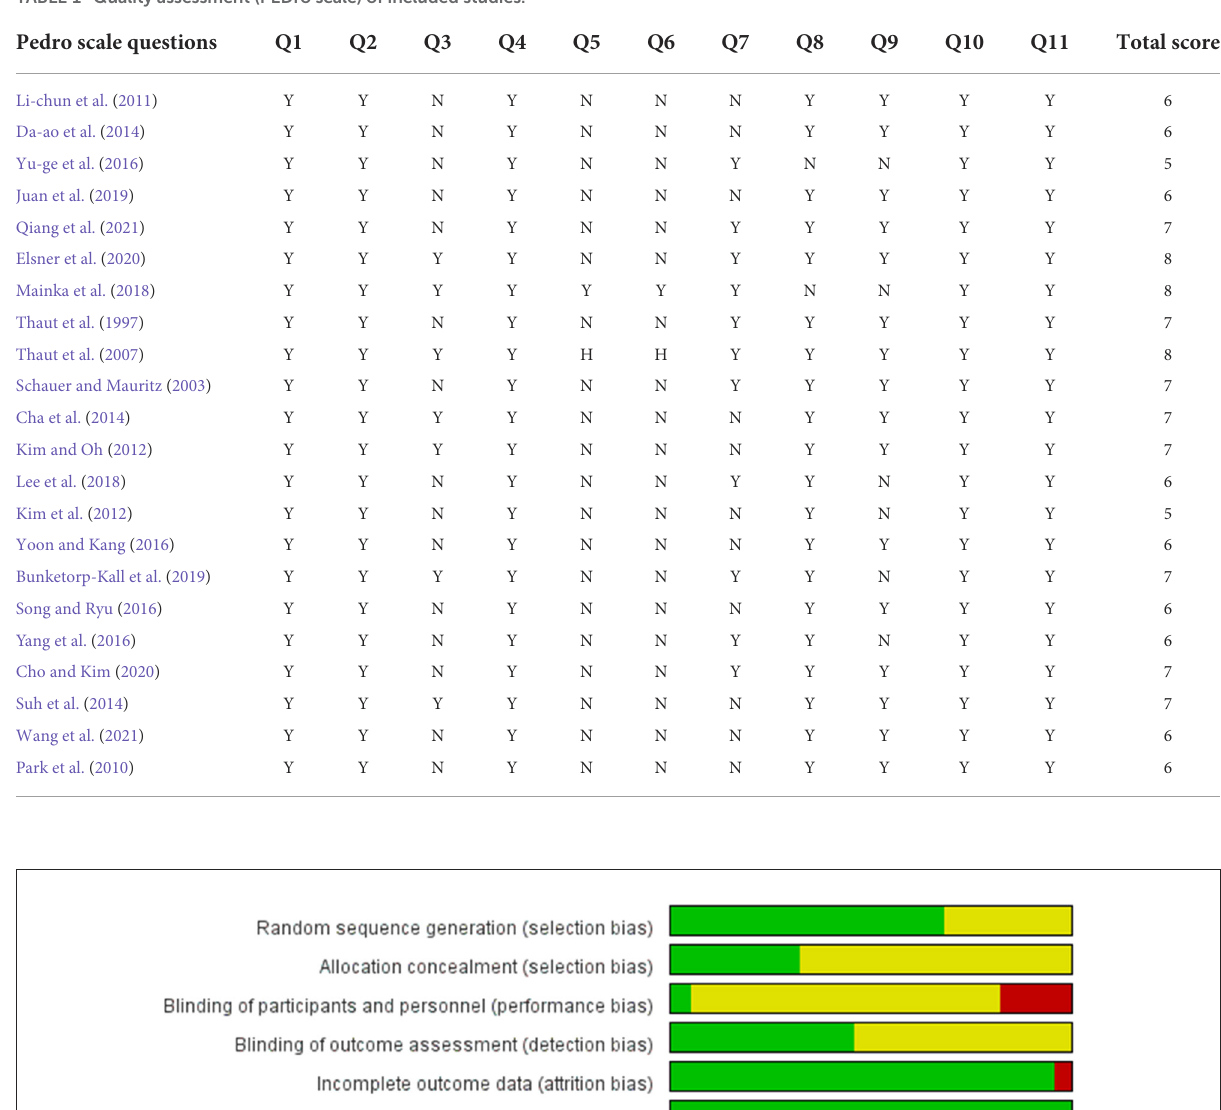
TABLE 1 Quality assessment (PEDro scale) of included studies.